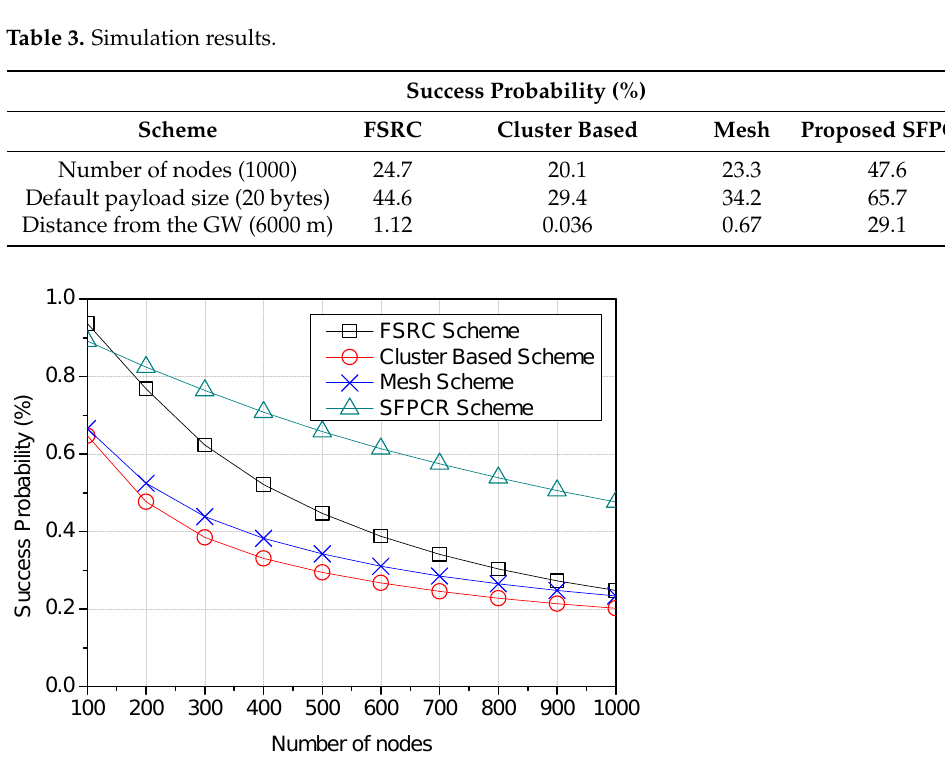
Figure 5. Plots variation in Success Probability according to the number of nodes in the network with a comparison between the SFPCR scheme and other